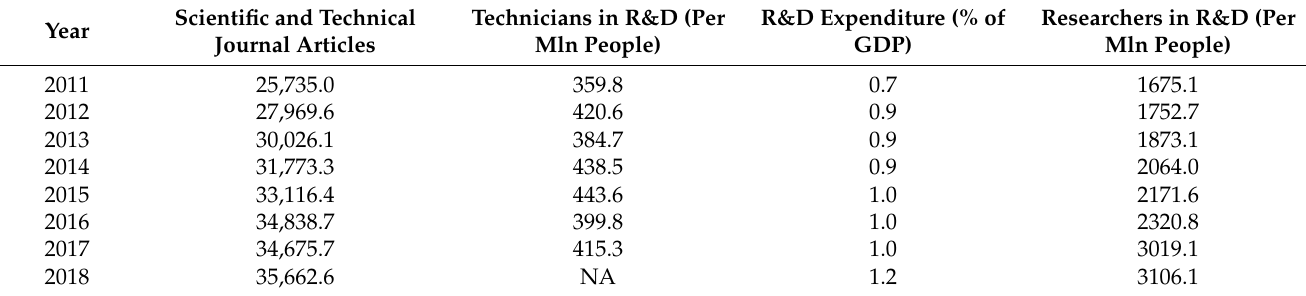
Table 7. Research and technology